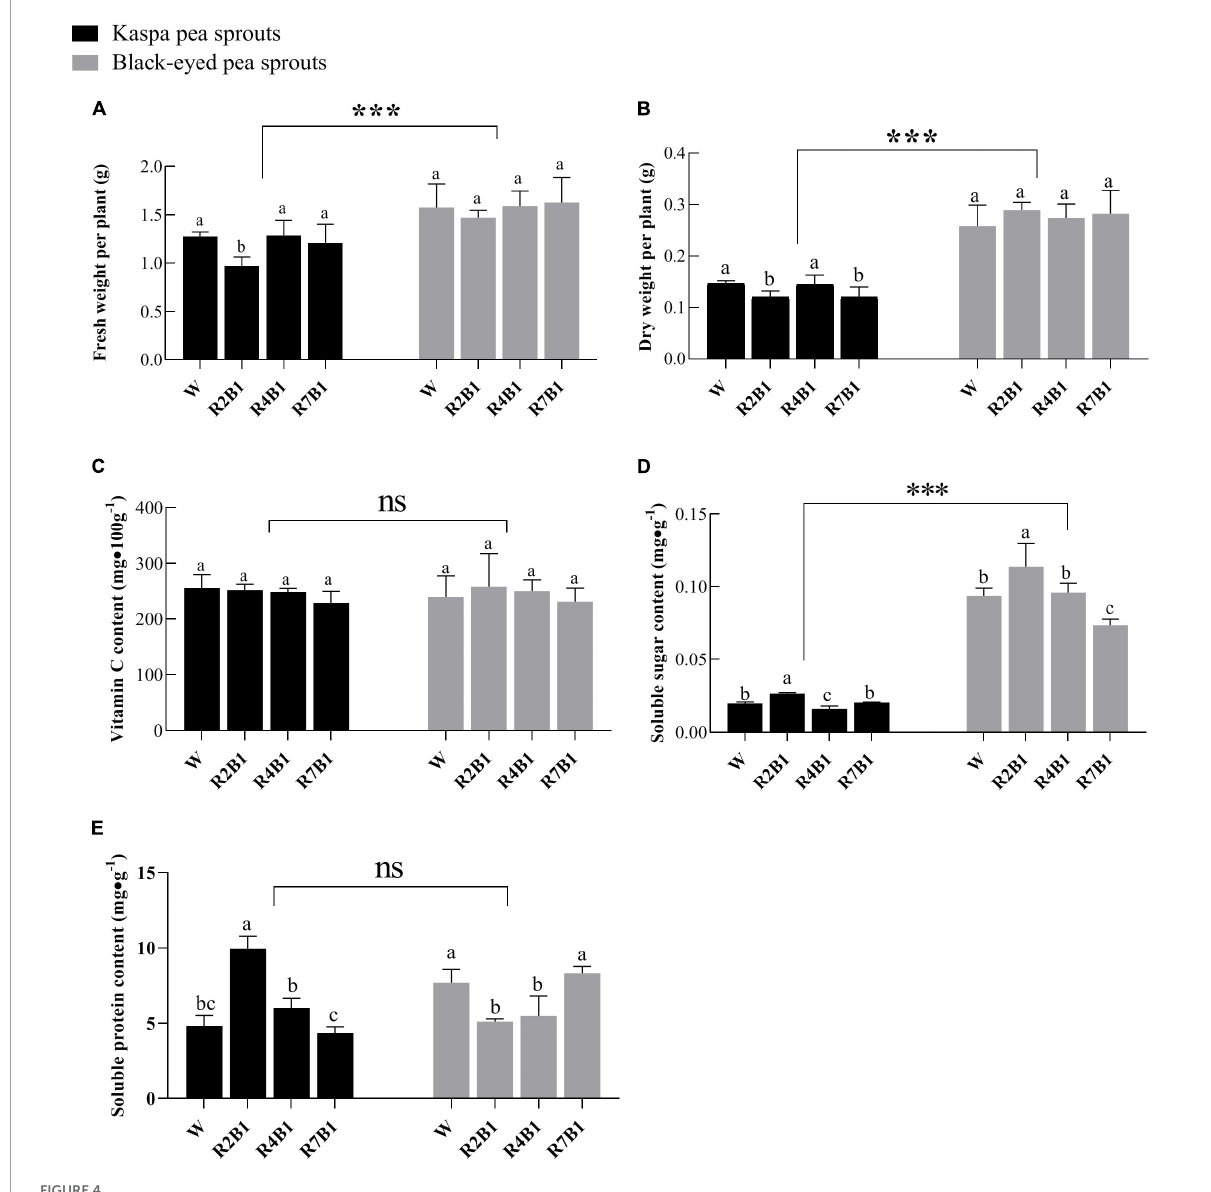
FIGURE4 Effects of different light quality combinations on the yield and quality of two varieties of pea sprouts. (A) Fresh weight per plant; (B) dry weight per plant; (C) vitamin C content; (D) soluble sugar content; (E) soluble protein content. Different letters indicate significant differences at P ≤ 0.05 of the same variety among treatments. ∗∗∗ Denotes significant differences at P ≤ 0.001 of different varieties, and ns means no significant difference. Error bars represent six